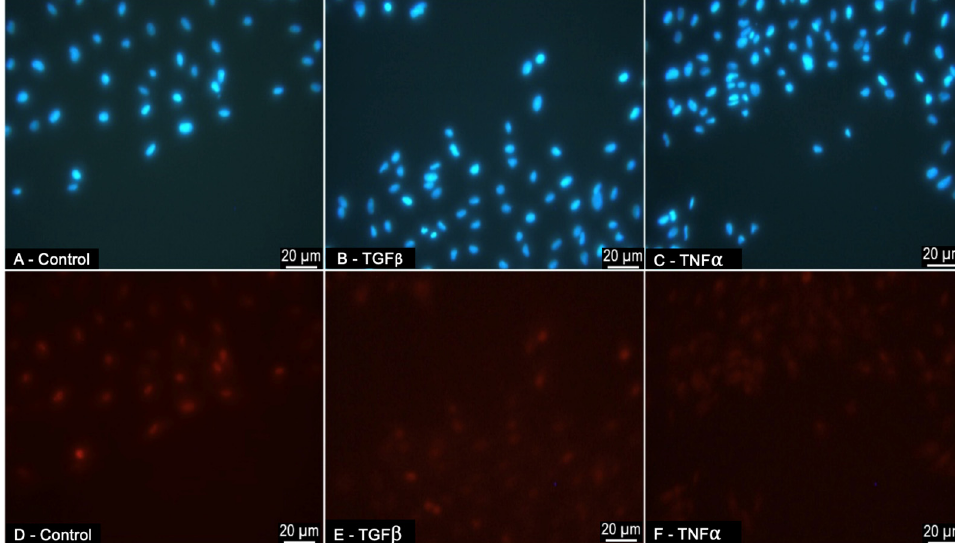
Figure 5. ARPE19-cell proliferation in response to treatment with pro-fibrotic cytokines ( B , E ) TGF β 1 and ( C , F ) TNF α during scratch migration assay. The ARPE19-cell immunofluorescence at the border of the scratch wound (20 × magnification). ( A – C ) Cells were stained for nuclear marker DAPI (blue) and ( D – F ) cell-proliferation marker Ki-67 (red). The number of Ki-67-positive cells was expressed as a percentage of DAPI-positive cells. This was ascertained by counting cells positively stained for Ki-67 and DAPI in a given field (with 15 ≤ cells, at 20× magnification):(Number of cells Ki-67 positive ÷ Number of cells DAPI positive) × 100. There were no significant differences between the levels of proliferation between the groups ( p > 0.05). (n = 3).